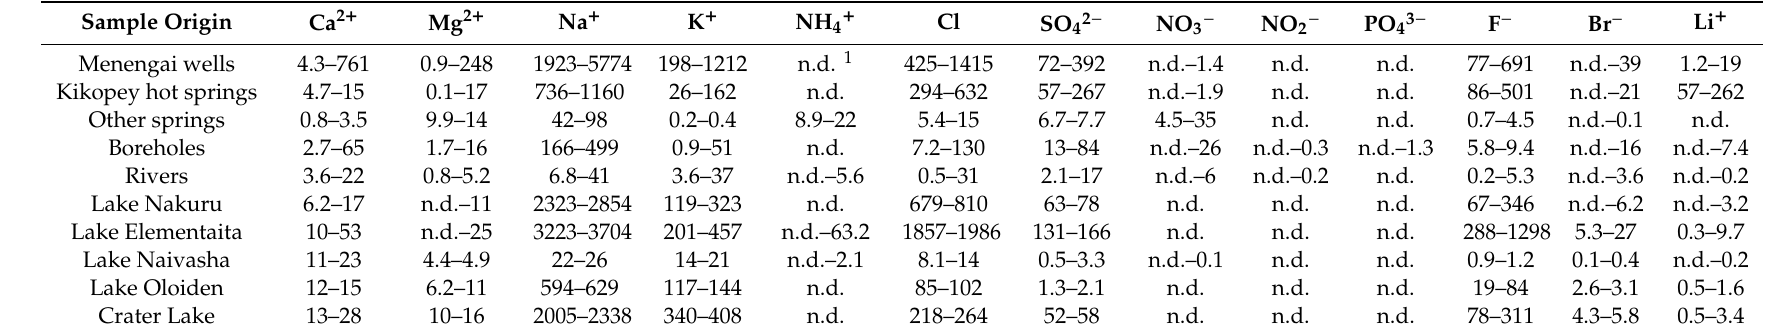
Table 3. Summary of major cation and anion lab analyses. All results in mg /